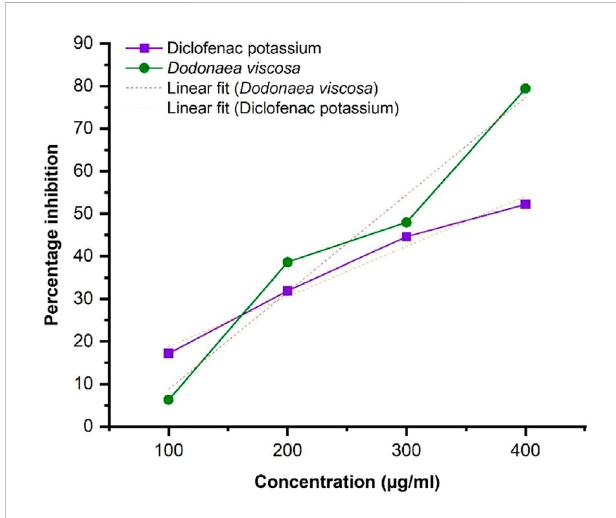
FIGURE 4 Protein denaturation activity of Dodonaea viscosa leaves.